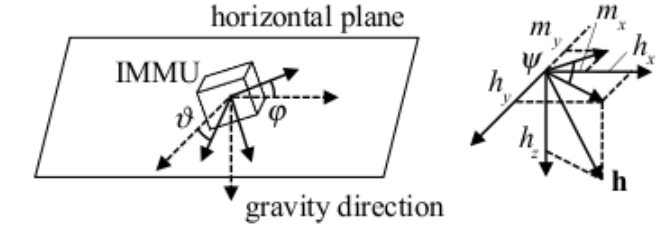
Figure 4. Inclination of the strap-down magnetic compass relative to the horizontal plane as defined by gravity